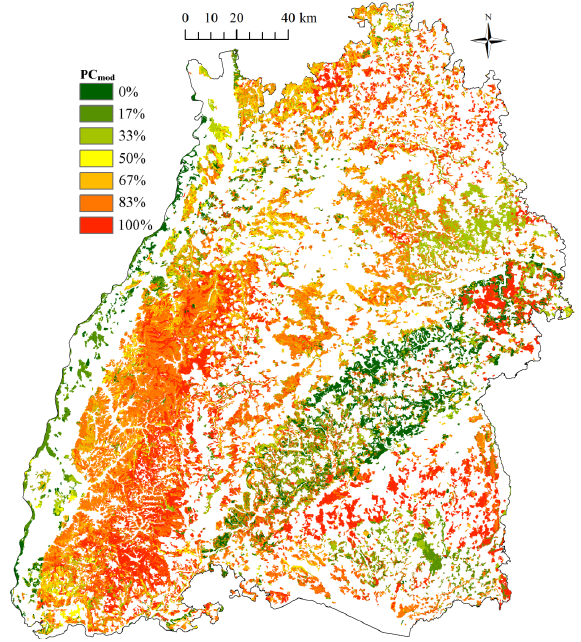
Figure 12. Map of modeled storm damage probability ( PC mod ).